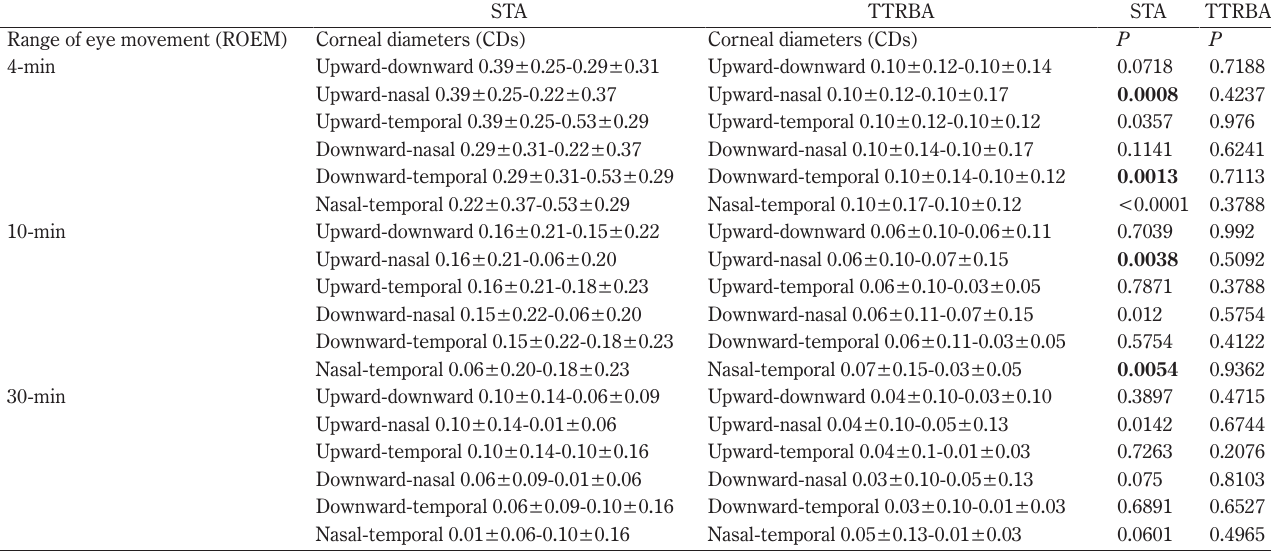
Table 2 Comparisons of directional differences of ROEM in sub-Tenon’s capsule anesthesia and trans-Tenon’s capsule retrobulbar anesthesia STA TTRBA STA TTRBA Range of eye movement (ROEM) Corneal diameters (CDs) Corneal diameters